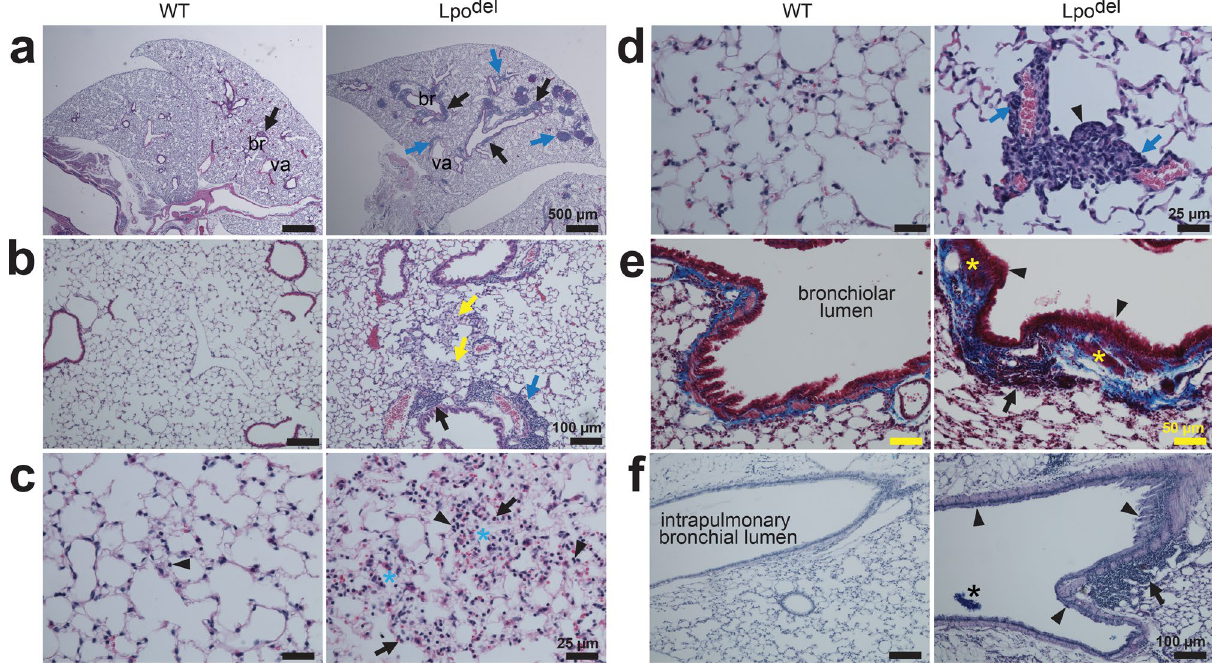
Figure 3. Pulmonary histopathology of Lpo del mice. ( a – d ) HE-stained sections. ( a ) The wild-type tissue section (left) exhibited a single small BALT (arrow), whereas the mutant section (right) exhibited numerous larger clusters around bronchioles (br, black arrows) and vasculature (va, blue arrows), with only some clusters indicated by arrows. ( b ) The mutant sample displayed infiltrating leukocytes around bronchioles (black arrow) or vasculature (blue arrow), and histiocytes (yellow arrows) in alveoli. ( c , d ) The mutant samples showed infiltrating leukocytes (black arrows, c ) scattered among diffuse, hyperplastic type II pneumocytes (arrowheads, c ) in a region with loss of alveolar structure (cyan asterisks, c ) or clustered infiltrating leukocytes (blue arrows, d ) in a thickened alveolar septum with type II pneumocyte hyperplasia (arrowhead, d ). ( e ) MT-stained sections exhibiting bronchioles. The mutant sample exhibited hypercellular epithelium (arrowheads), thickened muscularis (yellow asterisks), a patch of leukocyte infiltrates (arrow), and heavier collagen deposition (blue). ( f ) Sections containing an intrapulmonary bronchial branch where mucin in the epithelium and glycoproteins in the basement membranes were stained purple by ABPASH. In the mutant sample, mucin-producing goblet cells (arrowheads) in the epithelium were hyperplastic, and the basement membranes were thickened. There were a large patch of peribronchial inflammatory infiltrates (arrow) and a piece of mucus in the lumen (asterisk). Scale bars are 25 µm ( c , d ); 50 µm ( e ); 100 µm ( b , f ); 500 µm ( a